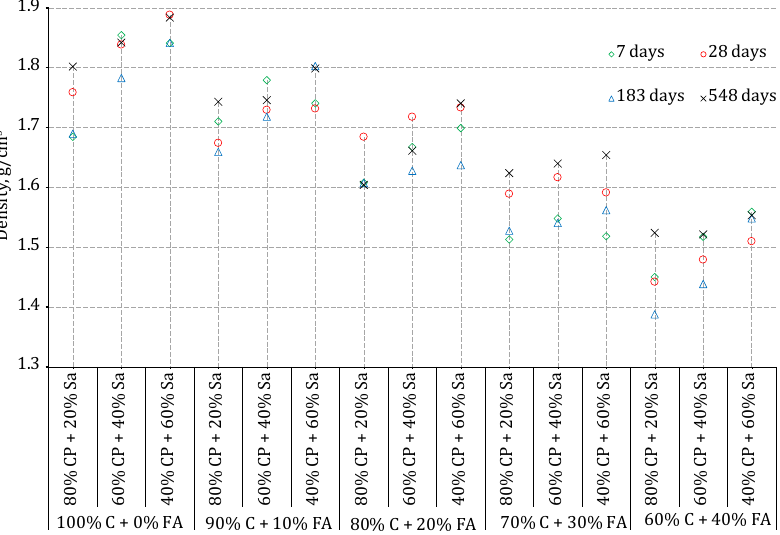
Figure 3. The density of investigated